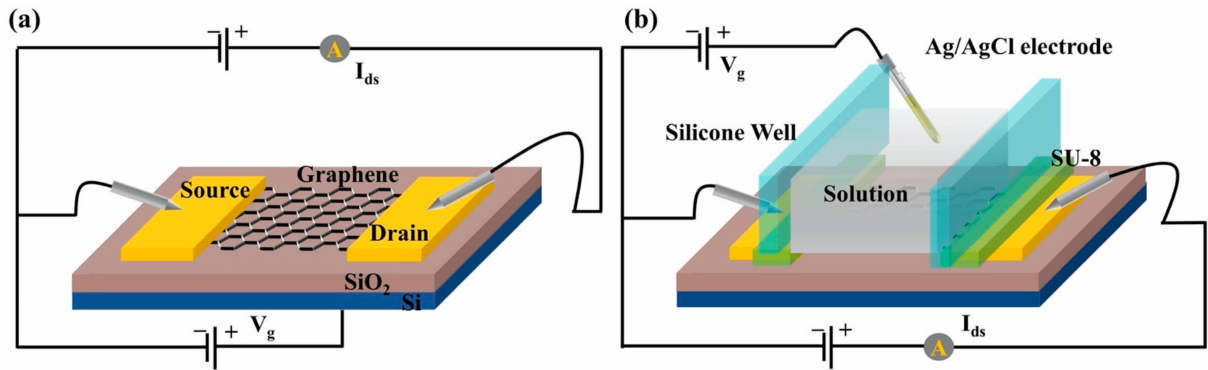
Figure 3. ( a ) The back-gate FET for gas-phase indole detection. ( b ) The solution-gate FET for liquid-phase indole